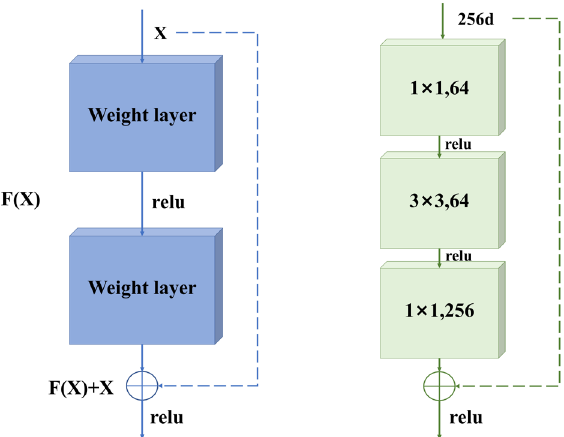
Figure 6. The shortcut connection ( left ) and bottleneck of ResNet ( right ).